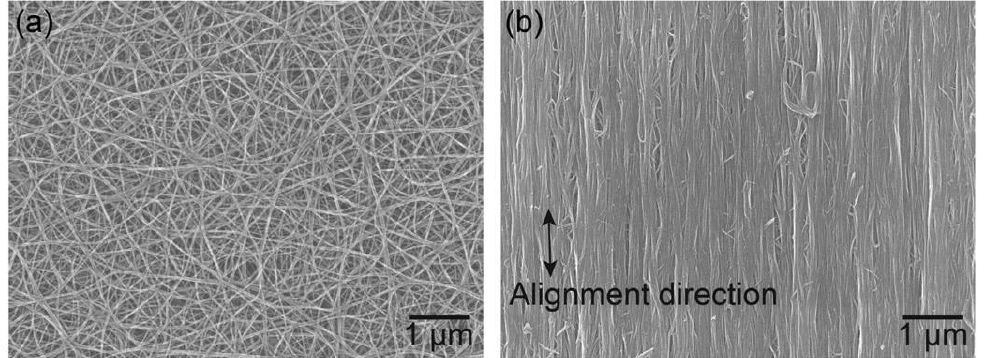
Figure 35. SEM images of ( a ) random and ( b ) aligned CNT sheets. Reprinted from [108], Copyright 2016, with permission from Elsevier.